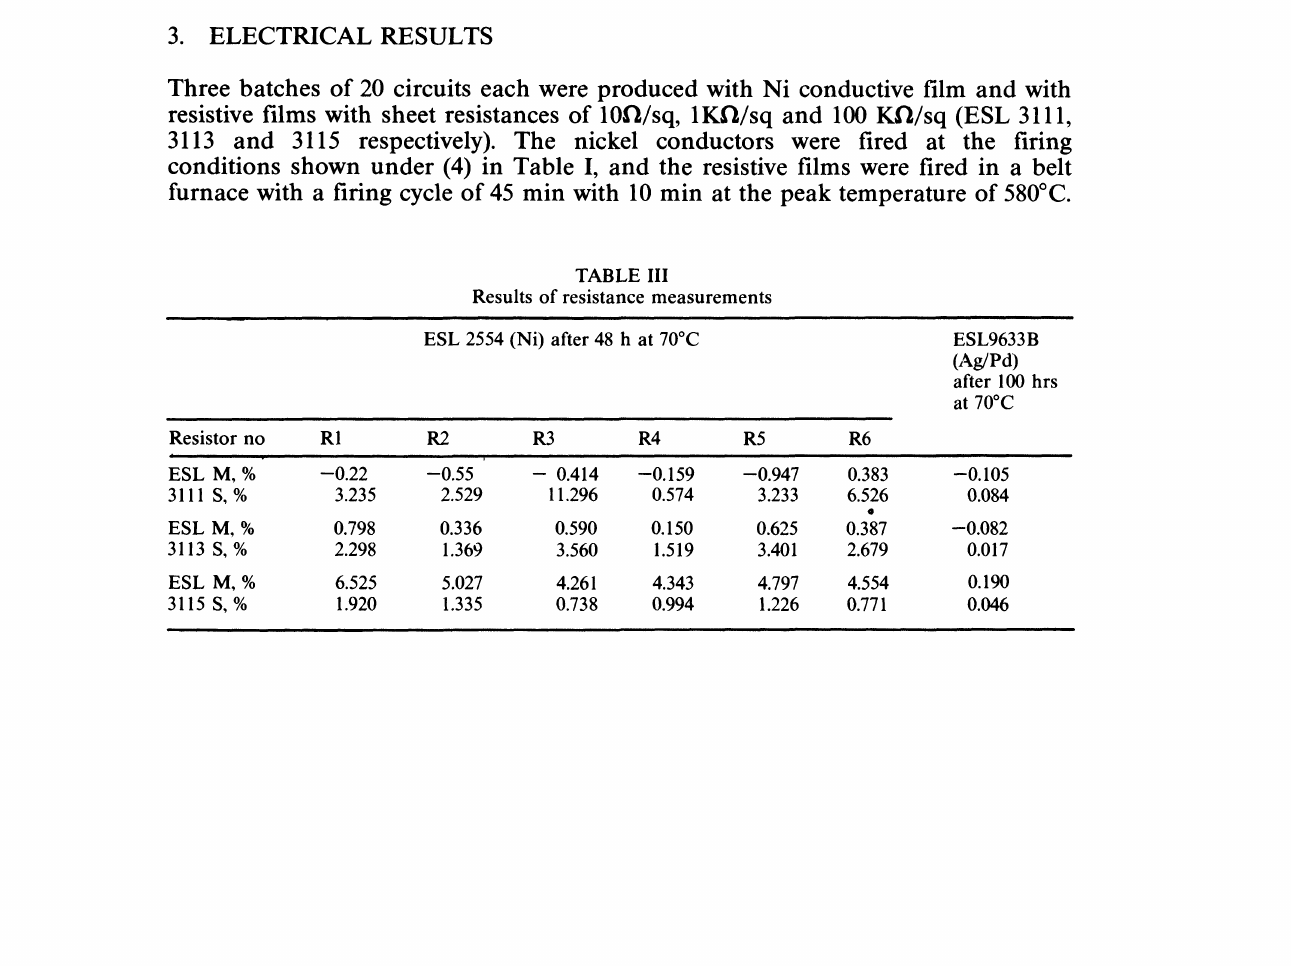
FIGURE 4 Ni thick film fired at peak temperature of 650C and tested under shelf conditions. (Substrate size 2" 1").